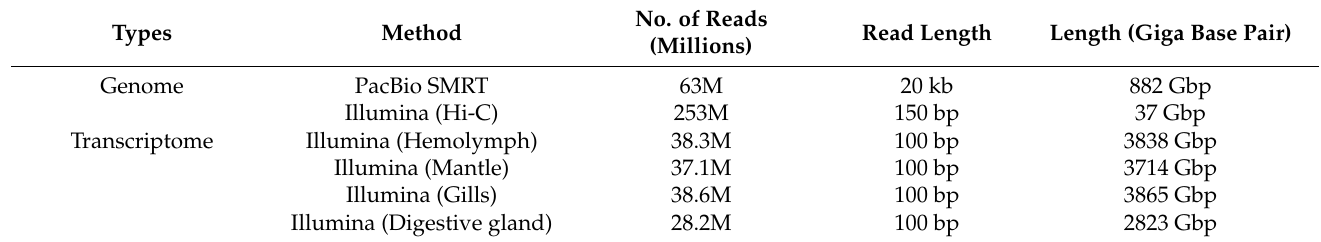
Table 1. Statistics of whole-genome sequence assembly and transcriptome analysis of the blue